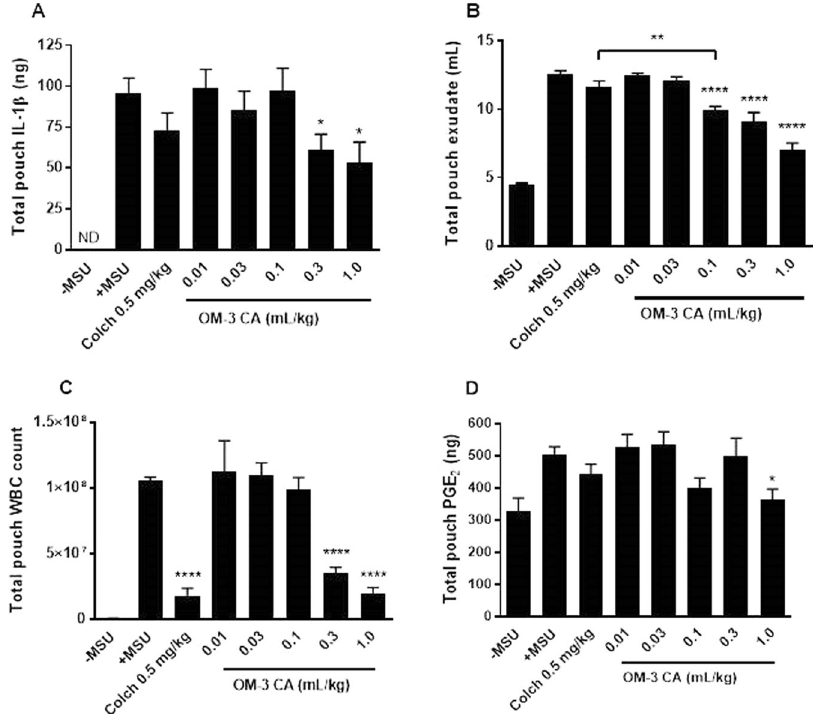
Figure 2. OM-3 CA efficacy in the rat MSU air pouch model tested using four endpoints. ( A ) Mean IL-1 β production assayed from the exudate recovered from the air pouches for each treated group (n = 10 per group). ( B ) Mean exudate volume recovered from the air pouches for each treated group. ( C ) Mean number of WBCs recovered from the air pouches for each treated group. ( D ) Pouch exudate PGE 2 content presented as mean ± standard error of the mean. * P < 0.05 versus + MSU using Dunn’s multiple comparison test ( A and D